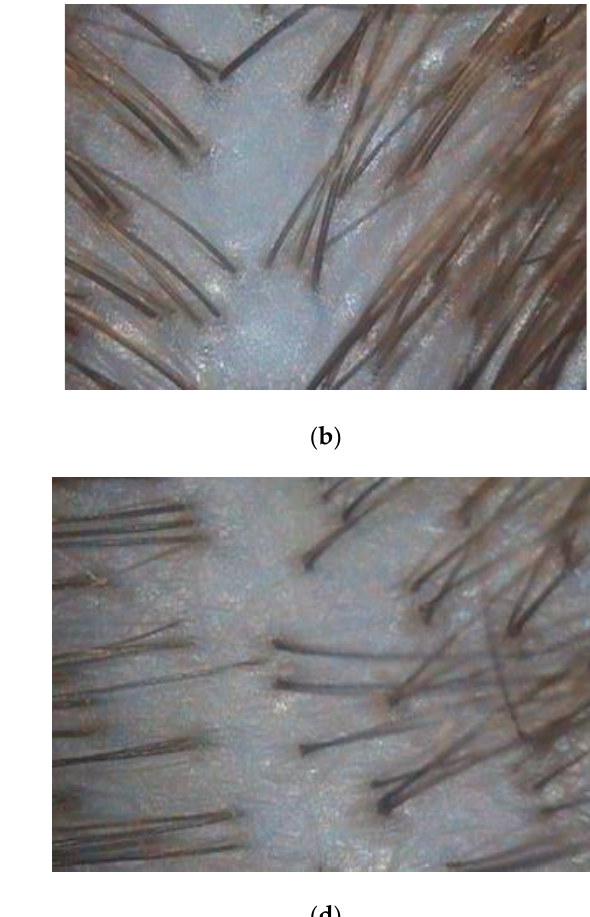
Figure A2. Microphotographs of hair density before and after the trial in the patient Ko-va of the placebo control Group 2. ( a ) Hair density on the frontal area before the trial; ( b ) hair density on the frontal area after the trial; ( c ) hair density on the occipital area before the trial; ( d ) hair density on the occipital area after the trial.